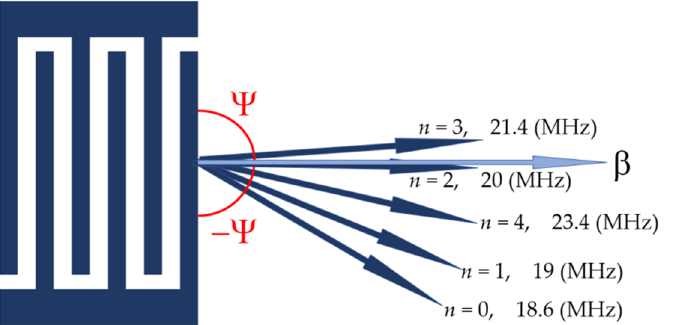
Figure 8. Schematic view of the fan-shaped power flow radiation from IDT on a plate surface for Lamb waves of different orders n (according to Table 2).